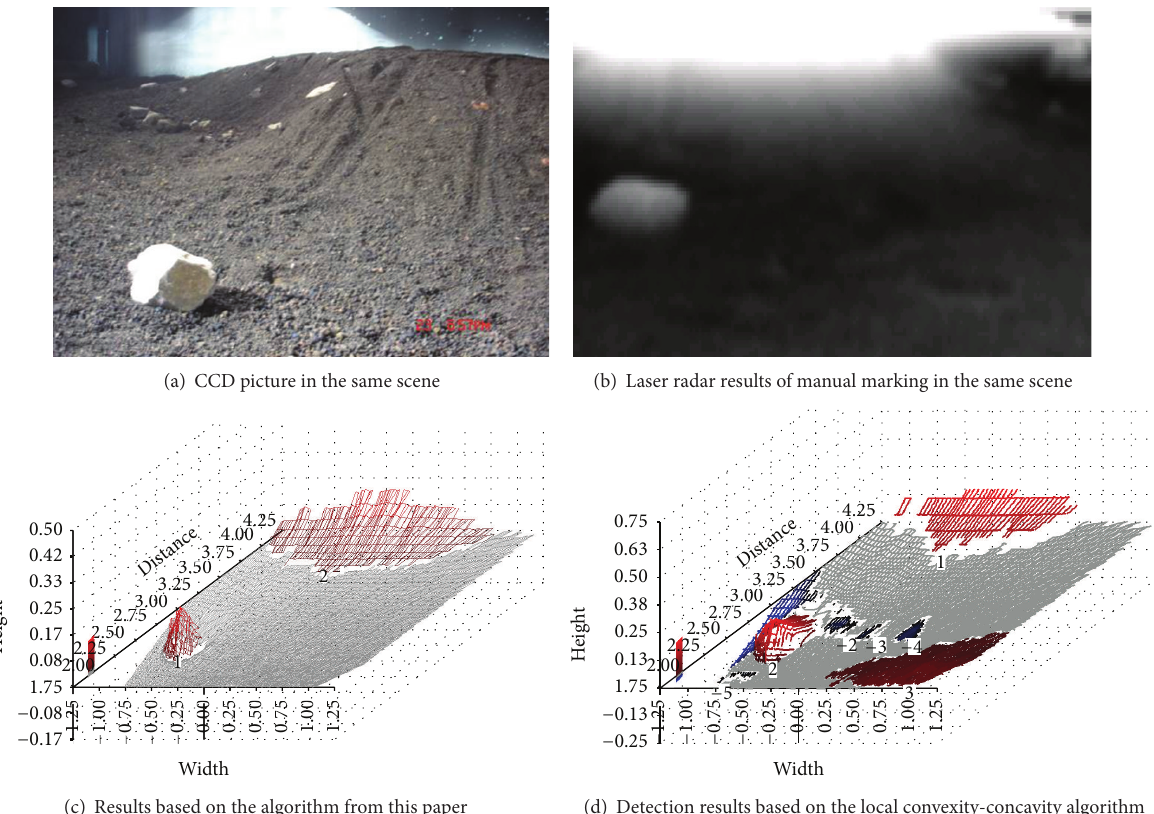
(d) Detection results based on the local convexity-concavity algorithm Figure 8: The results of positive obstacles in the cross-country